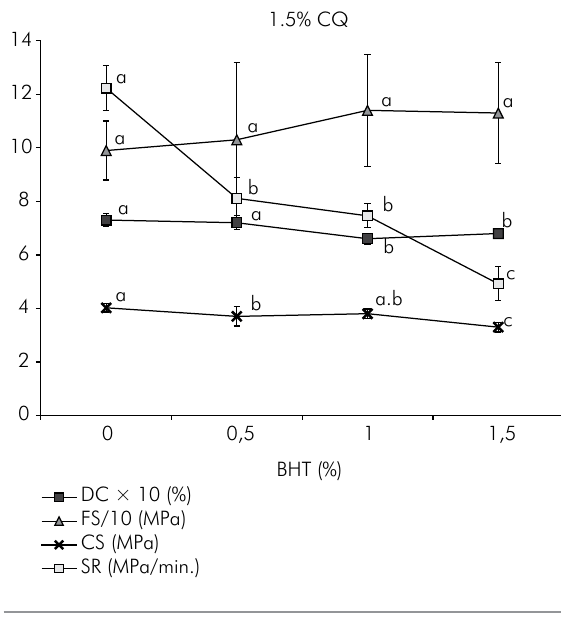
Figure 2. A graph illustrating the effect of increasing butylhydroxytoluene (BHT) concentration on the degree of conversion (DC), flexural strength (FS), contraction stress (CS), and stress rate (SR) of resin composite at the 1.5% camphorquinone (CQ) level. Different letters indicate significant differences within each property (p <